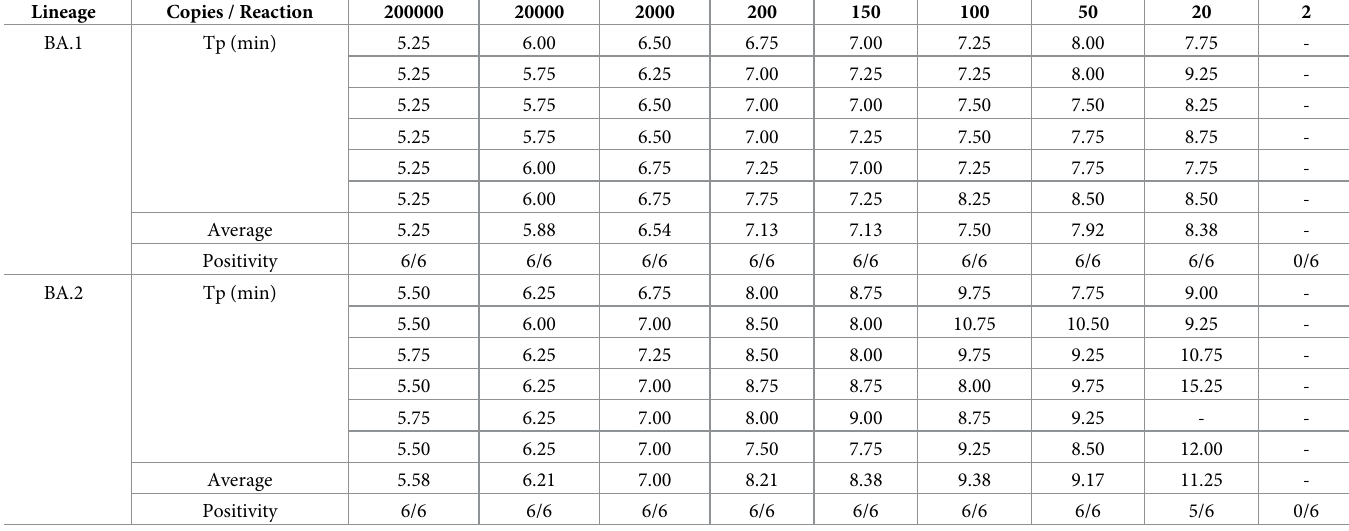
Table 4. Evaluation of the sensitivity of RT-LAMP assay for the detection of viral RNAs of Omicron variants. Lineage Copies /